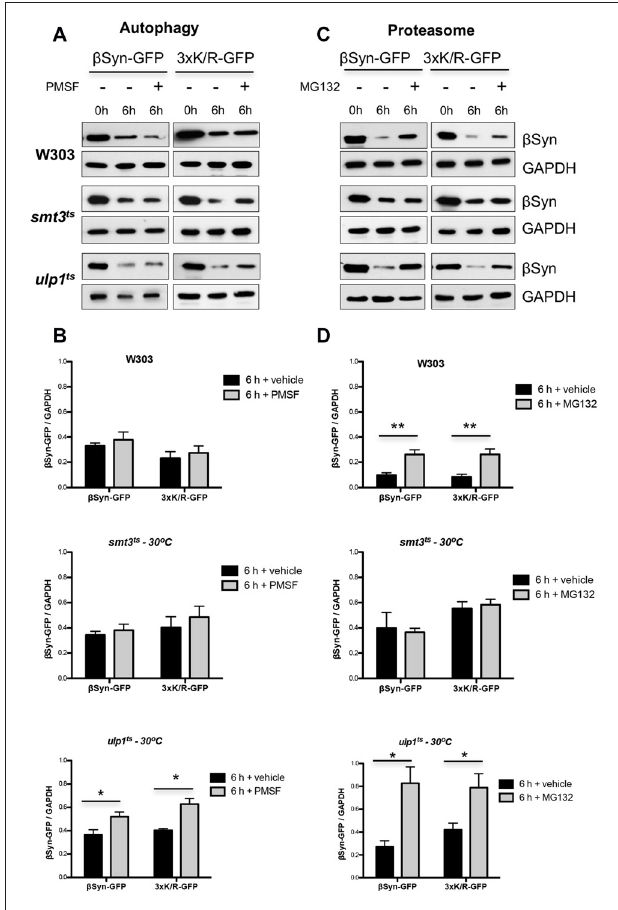
FIGURE 6 | Effect of sumoylation on β Syn protein stability. Yeast cells, expressing β Syn-GFP or 3xK/R-GFP variant in the indicated strains were induced for 4 h in galactose medium ( GAL1 “ON”) and then transferred to glucose containing medium ( GAL1 “OFF”). The glucose medium was supplemented with 1 mM PMSF (A) or 75 µ M MG132 (C) . Immunoblotting analysis was performed at the indicated time points after promoter shut-off with β Syn antibody and GAPDH as a loading control. A representative result is shown from at least three independent experiments. (B,D) Densitometric analysis of the immunodetection of β Syn relative to the GAPDH loading control. Significance of differences was calculated with t -test ( ∗ p < 0.05; ∗∗ p < 0.01; n =